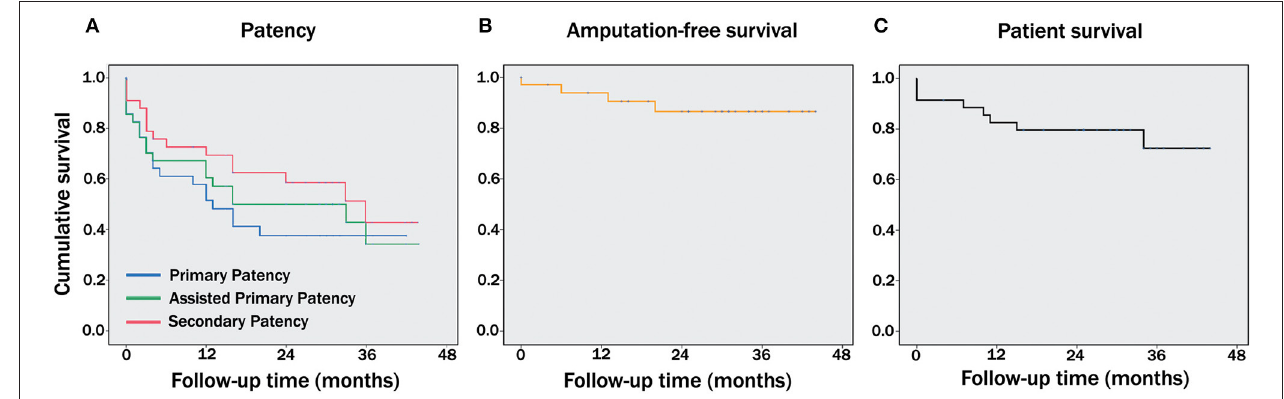
FIGURE 1 | Kaplan-Meier survival functions showing long term outcomes. Cumulative survival curves for bypass patency, including primary, primary assisted and secondary patencies (A) , amputation-free survival (B) , and patient survival (C) .